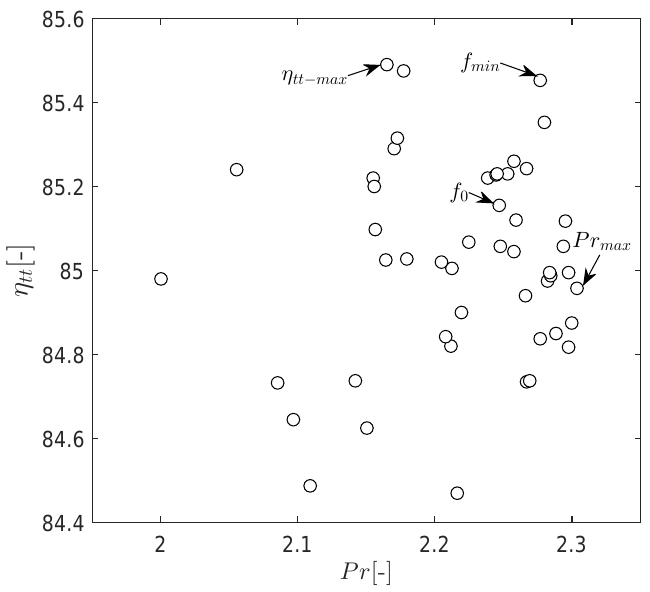
Figure 17. Isentropic efficiency versus pressure ratio for design space.